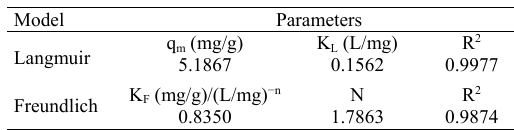
Table 1. Langmuir and Freundlich model correlation coefficients and constants for adsorption of Cd 2+ on the absorbent at ambient